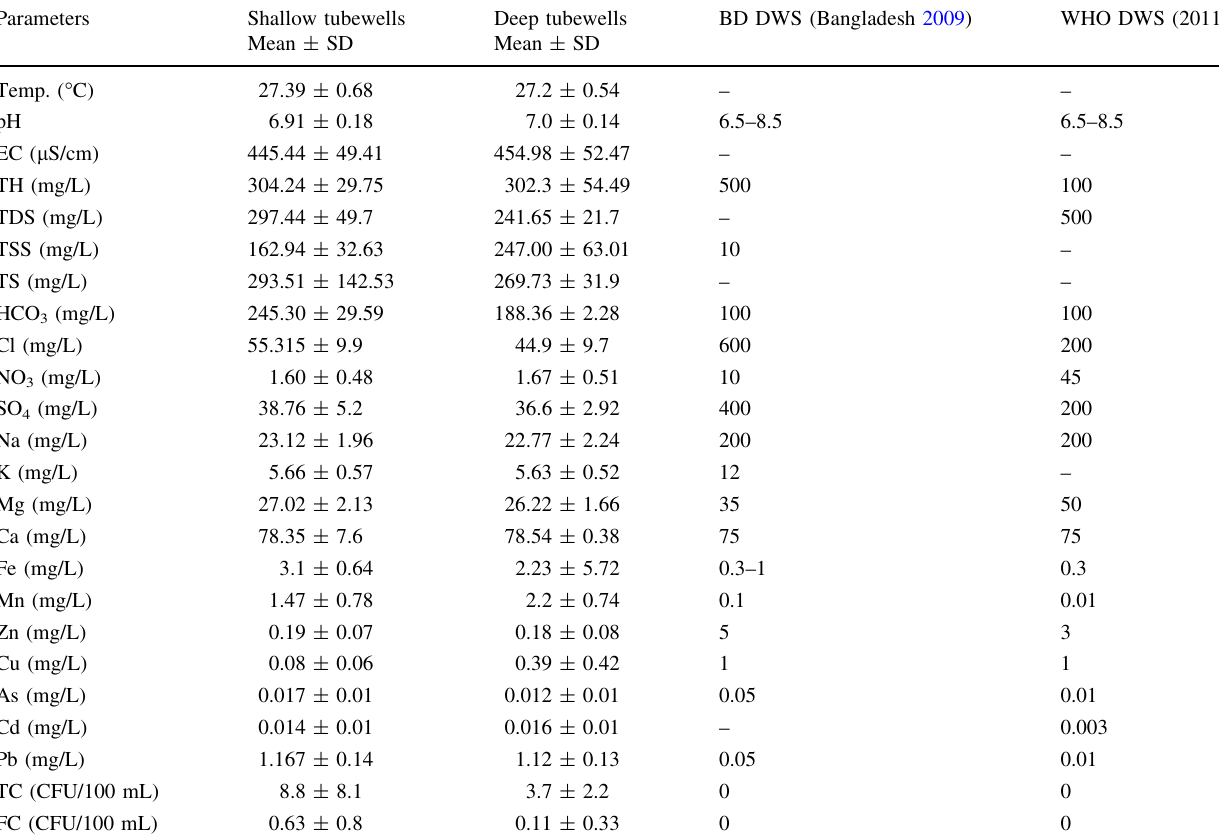
Table 2 Statistical summary of physicochemical and microbial parameters of groundwater of Rajshahi City and their comparison with the WHO and Bangladesh standards for drinking water